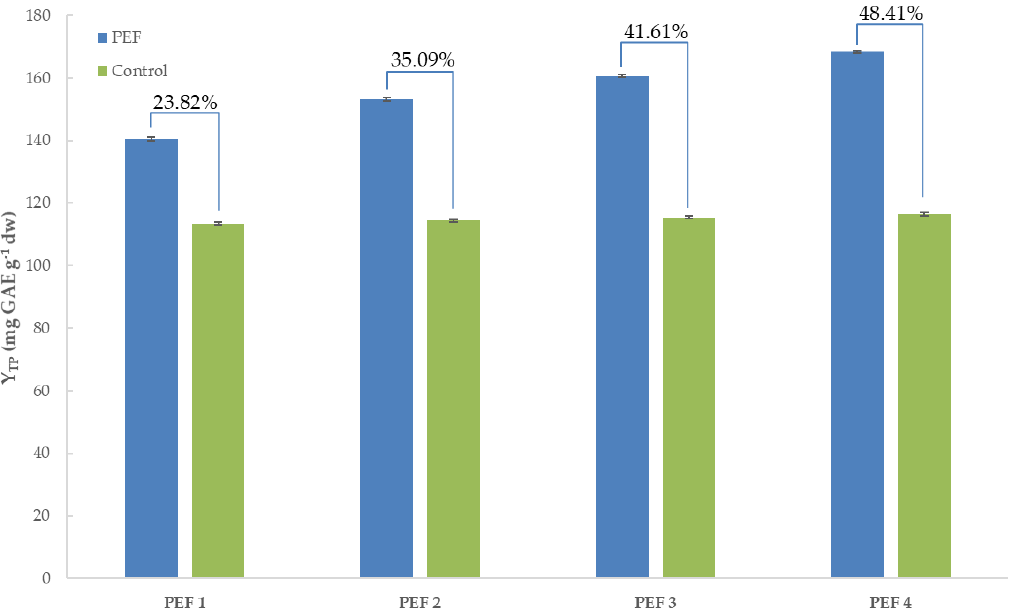
Figure 3. Total phenolics, Y TP , for Castanea sativa leaves PEF samples in different electric field intensities, compared to control samples.